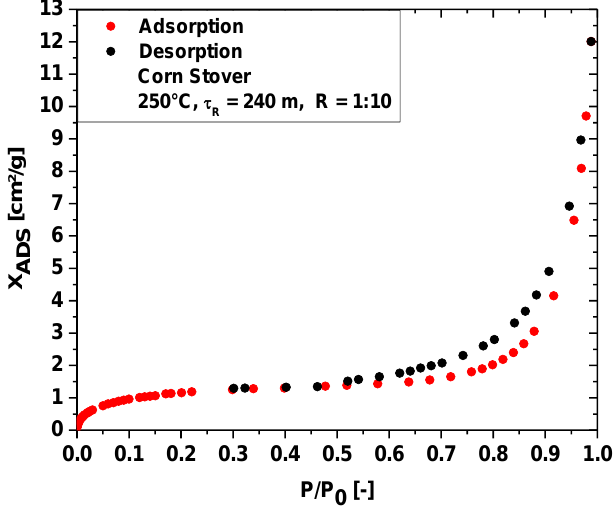
Figure 13. Solid phase capacity (X ADS ) versus relative pressure (P/P 0 ) for hydro-char obtained by HTC of corn stover at 250 °C after 240 min with a biomass-to-H 2 O ratio of 1:10 in a pilot-scale reactor of 18.75 L.